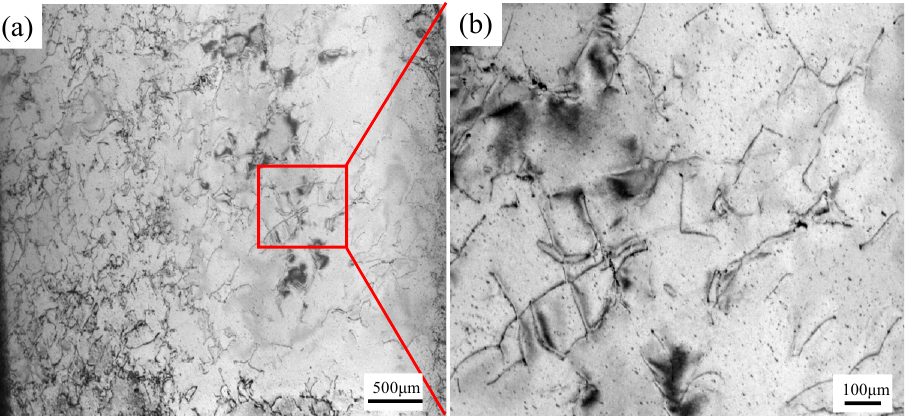
Figure 4. TEM microstructure of the Ni-23Cr alloy lattice: ( a ) bright-field image of the NiCr alloy lattice, ( b ) enlarged view of the red area in ( a ).